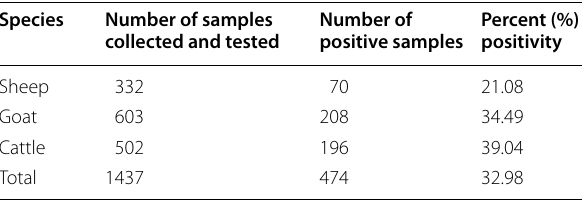
Table 8 Seroprevalence of anti-BTV antibodies among Manipur